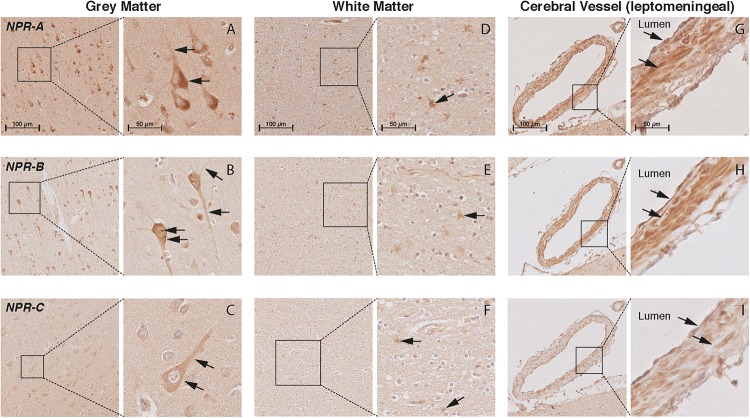
Localization of NPR-A, NPR-B, and NPR-C in the frontal cortex of non-demented controls. NPR immunohistochemistry in the frontal lobe (middle frontal gyrus) of non-demented controls. (A–C) NPR-A, NPR-B, and NPR-C-positive neurons. Arrows point to the cytoplasm (all NPR), neuronal processes (all NPR), and Nissl bodies (NPR-A); (D–F) NPR-A, NPR-B, and NPR-C-positive astrocyte-like cells in the white matter; (G–I) NPR-A, NPR-B, and NPR-C-positive endothelium and smooth muscles in leptomeningeal vessels.